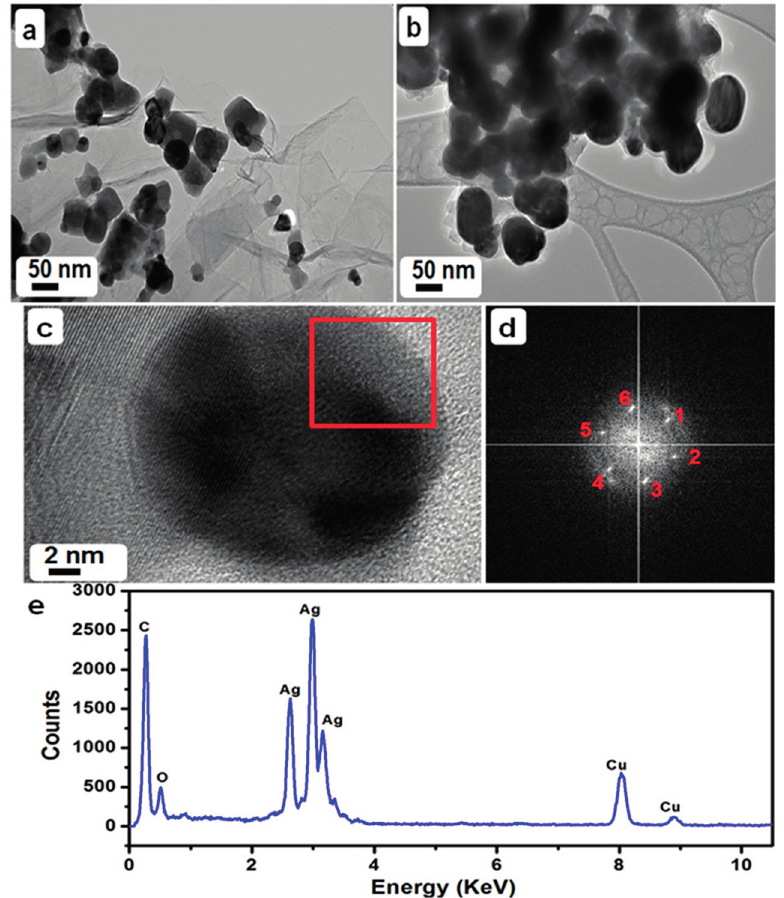
Figure 2. ( a , b ) Overview TEM images of the graphene/silver nanocomposites prepared by using a 50 wt %, 0.5 mmol solution of AgNO 3 (PE-HRG-Ag-1) and a 100 wt %, 0.5 mmol solution of AgNO 3 (PE-HRG-Ag-2); ( c ) High resolution transmission electron microscopic (HRTEM) image of a Ag NP; ( d ) FFT measured inside red square in Figure 2c, numbers 1–6 represent important reflections which confirms the cubic structure of Ag NP; and ( e )